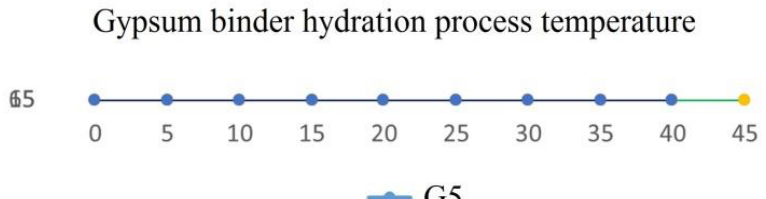
Figure6 Impact of the content of fractions of finely ground gypsum on the hydration